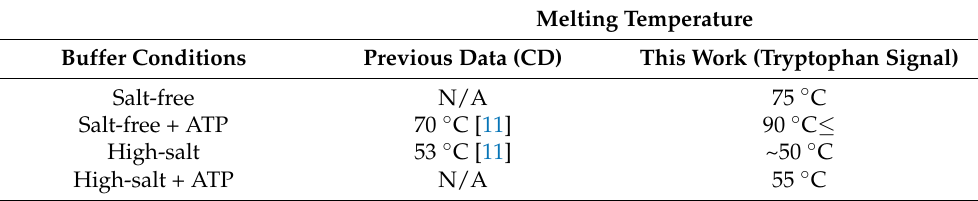
Table 1. Results of thermal denaturation of Tm -MreB. Second-order differentiation was performed using the data in Figure 2 to obtain the decay of the fluorescence signal, i.e., melting